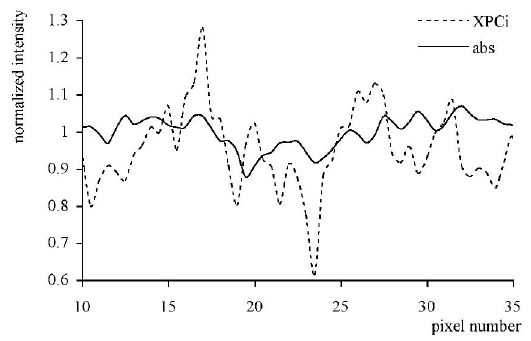
Figure 9. Profiles of the 300 µm polyethylene wire extracted from the XPCi (dashed line) and from the absorption (solid line) images of Figures 7(a,b) respectively. The profile corresponds roughly to the position indicated by the top arrow in Figure